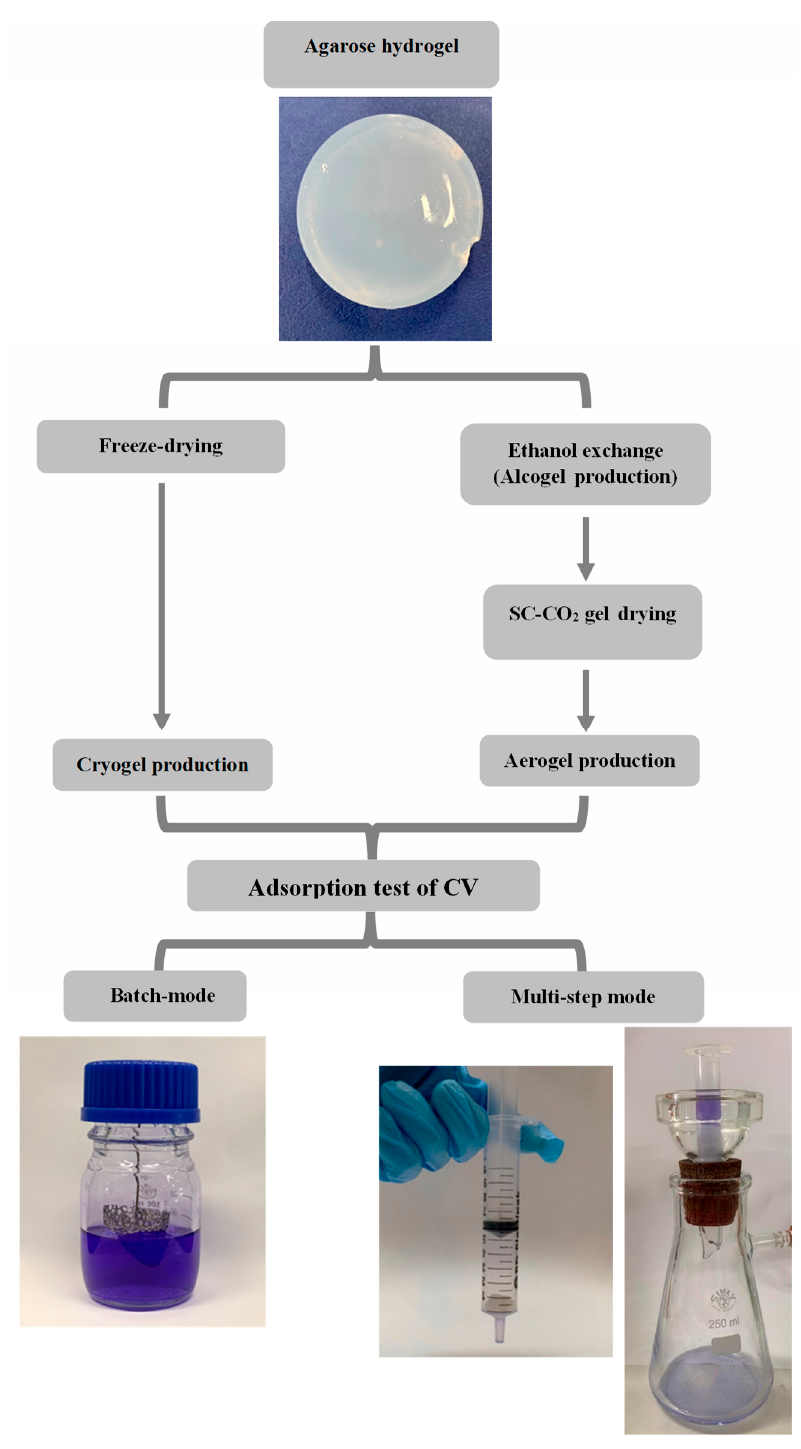
Figure 1. Aerogel and cryogel preparation method and representation of the different adsorption experiments.